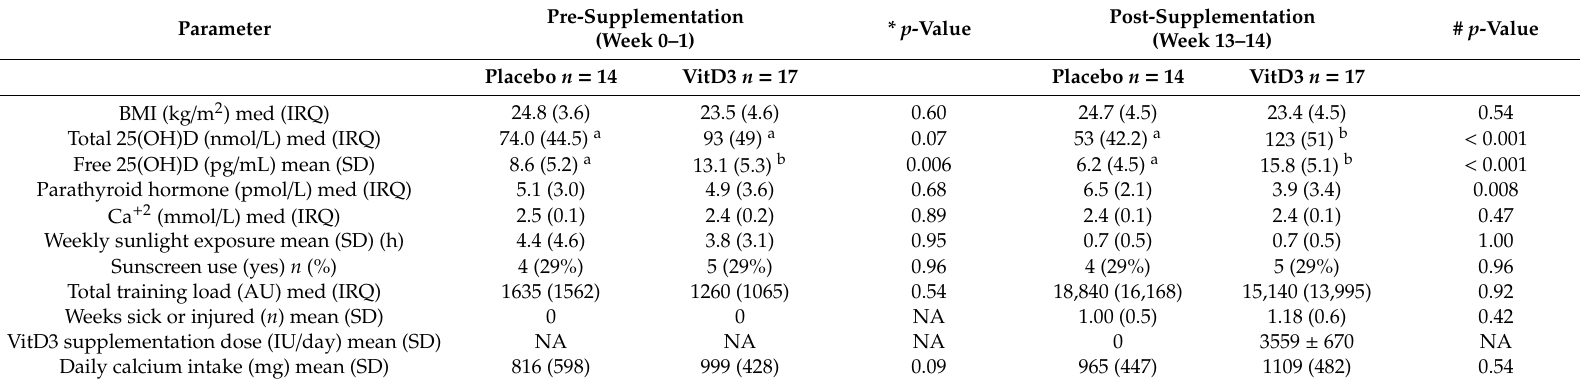
Table 1. Pre- and post-supplementation characteristics of participants by study group (placebo n = 14 and VitD3 n =